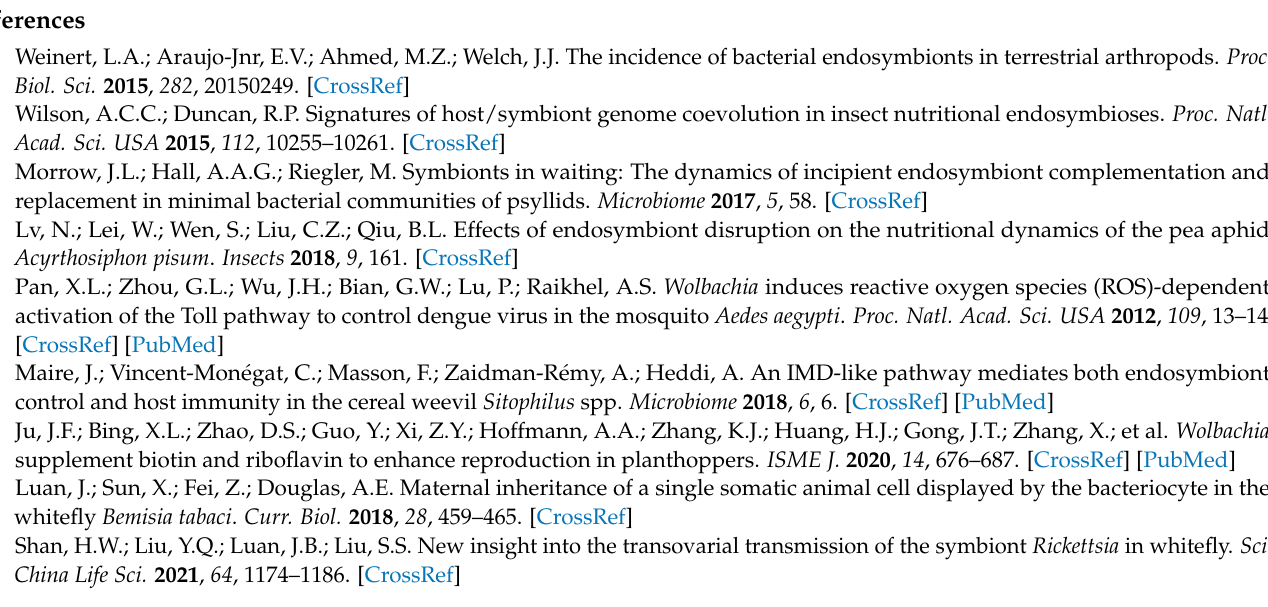
Figure S3: Ct value of beta-actin gene in whitefly eggs at different time Error bars represent the standard error of the mean; n = 3 biological replicates; Figure S4: Ct value of coxA gene in whitefly eggs at different time Error bars represent the standard error of the mean; n = 3 biological replicates; Figure S5: Ct value of gltA gene in whitefly eggs at different time Error bars represent the standard error of the mean; n = 3 biological replicates; Table S1: The primers and reaction program for PCR detection of endosymbionts in Asia II1 B. tabaci ; Table S2: The information of oligonucletide primers used in quantitative PCR